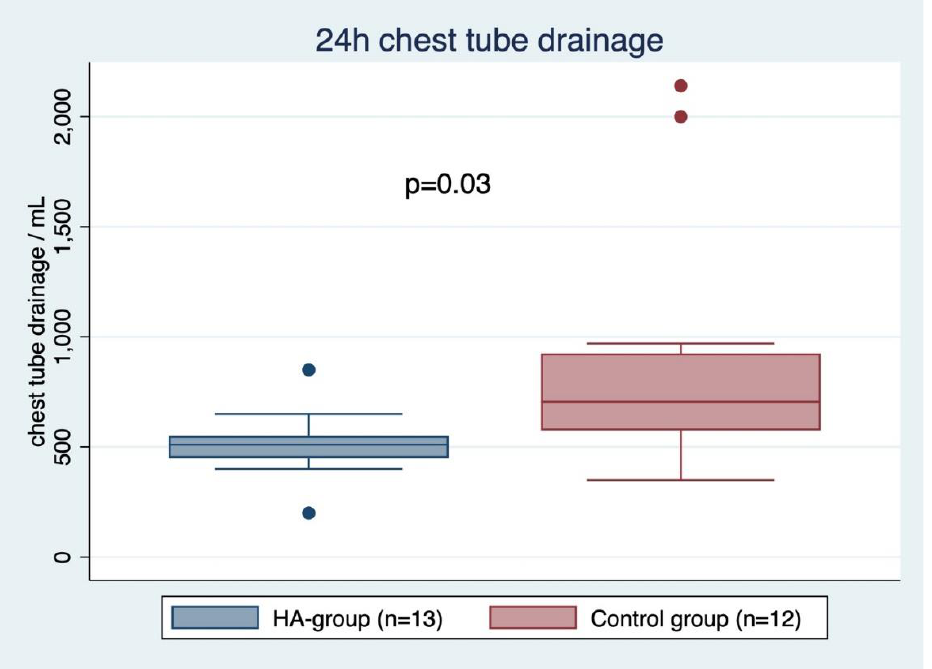
Figure 2. Box plot of chest tube drainage (including minimum, first quartile, median, third quartile and maximum). Table 2. Operative and postoperative characteristics.